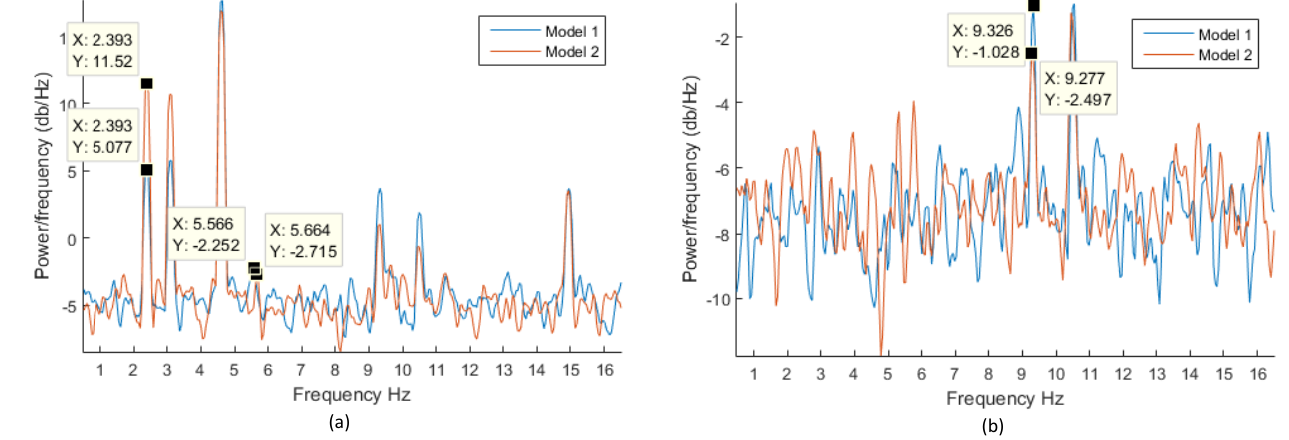
Figure 18. Comparison between the first and the second models using selected parameters. ( a ) Channel X. ( b ) Channel Z.